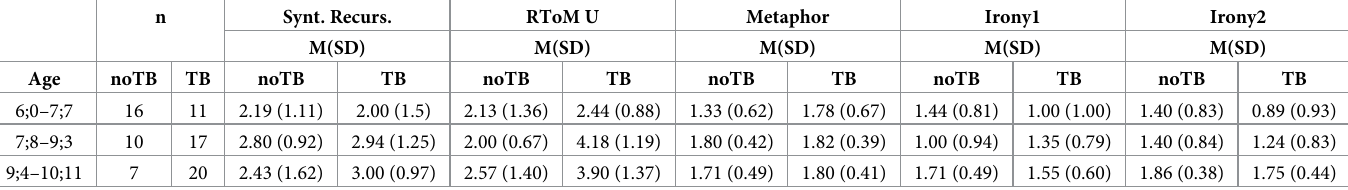
Table 3. Mean performance (M) and standard deviations (SD) in Syntactic Recursion (Synt. Recurs.), Recursive ToM Understanding (RToM U), metaphor under- standing (Metaphor), irony understanding in the first and second test question (Irony1 and Irony2) and for TB non-passers (noTB) and TB passers (TB) in three groups of age. n Synt. Recurs. RToM U Metaphor Irony1 Irony2